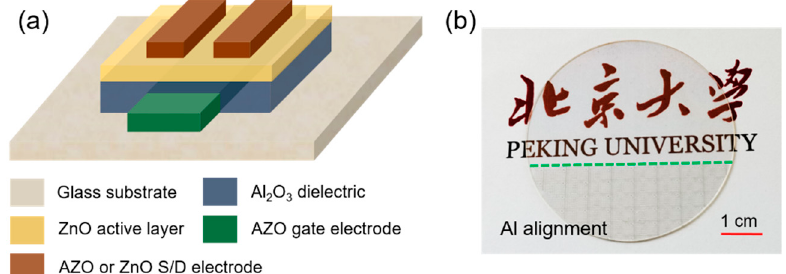
Figure 8. ( a ) Schematic device structure of ZnO TFTs. ( b ) Photo image of ZnO TFTs. ZnO and AZO films are used as S/D electrode.